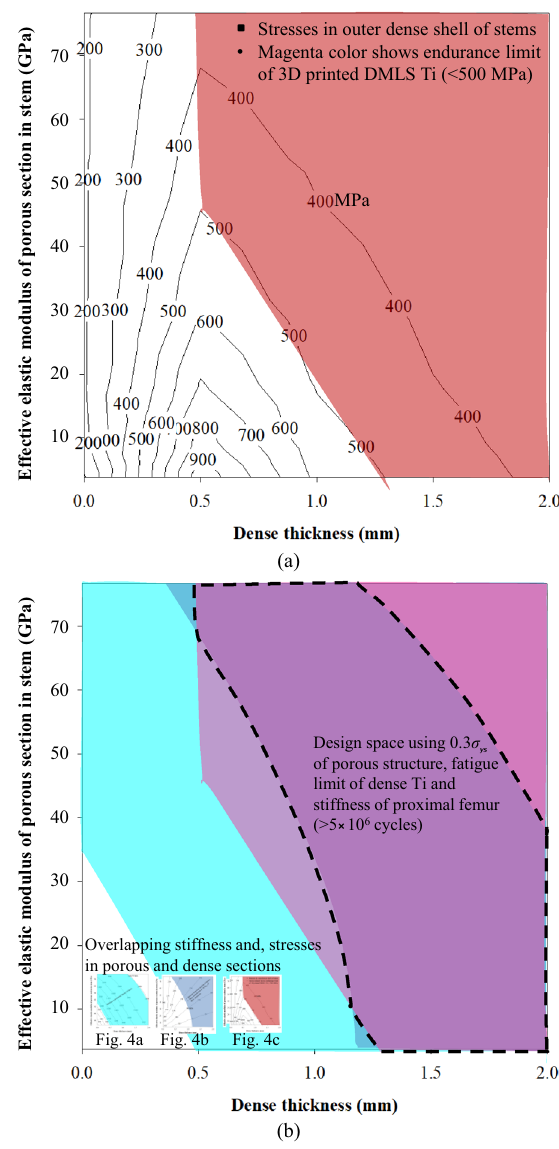
Fig. 5 Results of stresses in dense section and design space of porous stems; a stresses in dense outer shell shown in magenta color to be safe under fatigue load, b a design space determined using stiffness, stresses in porous section and stresses in a dense section (Color fi gure